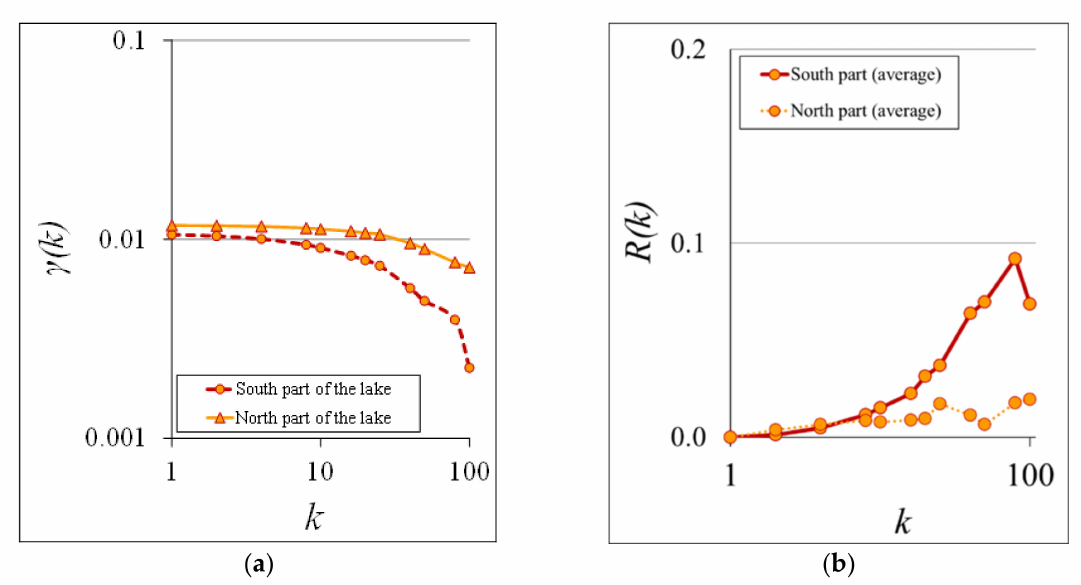
Figure 10. ( a ) Evaluation climacograms with the alteration of original vs. transformed scenery; ( b ) averages of the north and south part of the